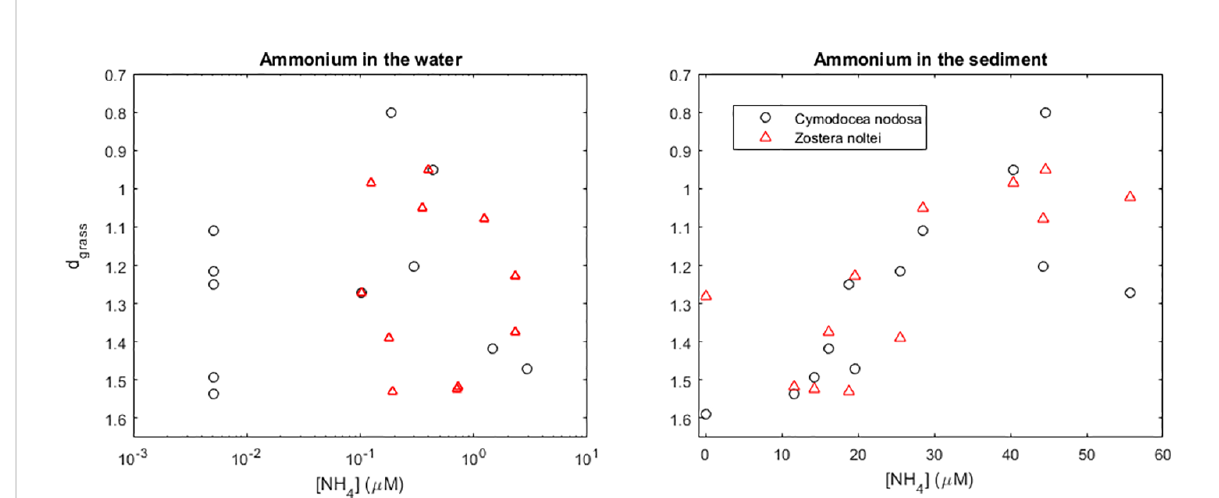
FIGURE 4 Health of Cymodocea nodosa and Zostera noltei meadows in the Bay of Naples, Italy, and their relation with the ammonium concentration in the water and sediment. Seagrass health is indicated by their distance (d grass ) to the seagrass IBL (i.e., their ef fi ciency of space occupation). In some locations, samples were taken from both the middle (Middle) and the edge (Edge) of the meadow. Trends fi t by maximum likelihood estimation